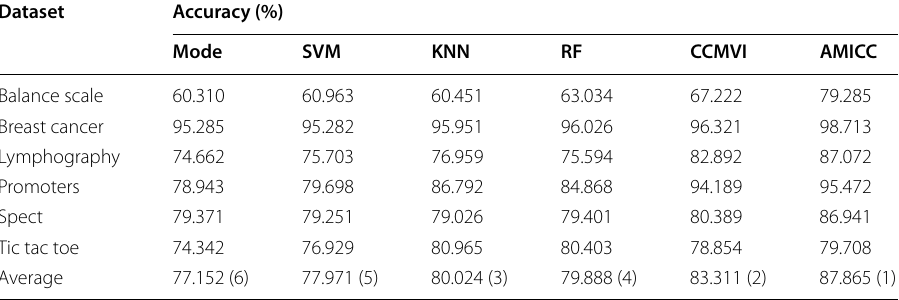
Table 8 Average classification accuracies of the MVI methods for the categorical datasets Dataset